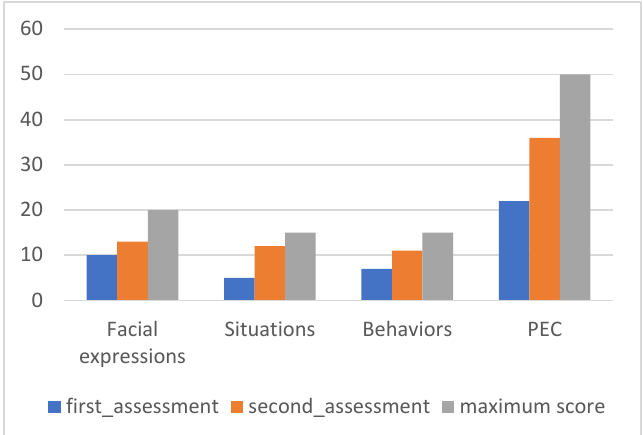
Figure 3. Maria’s PEC results.